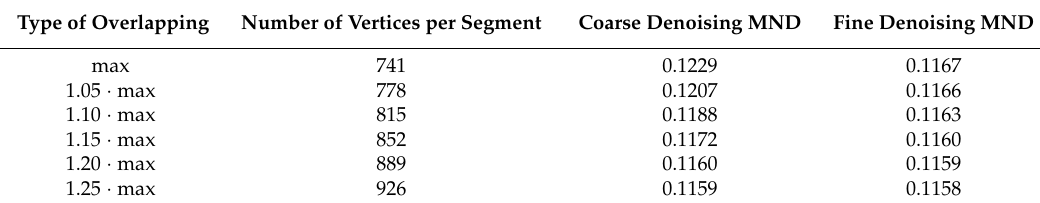
Table 5. Mean normal difference using different size of equal-sized overlapped submeshes (Julio Model with 36,201 vertices 50